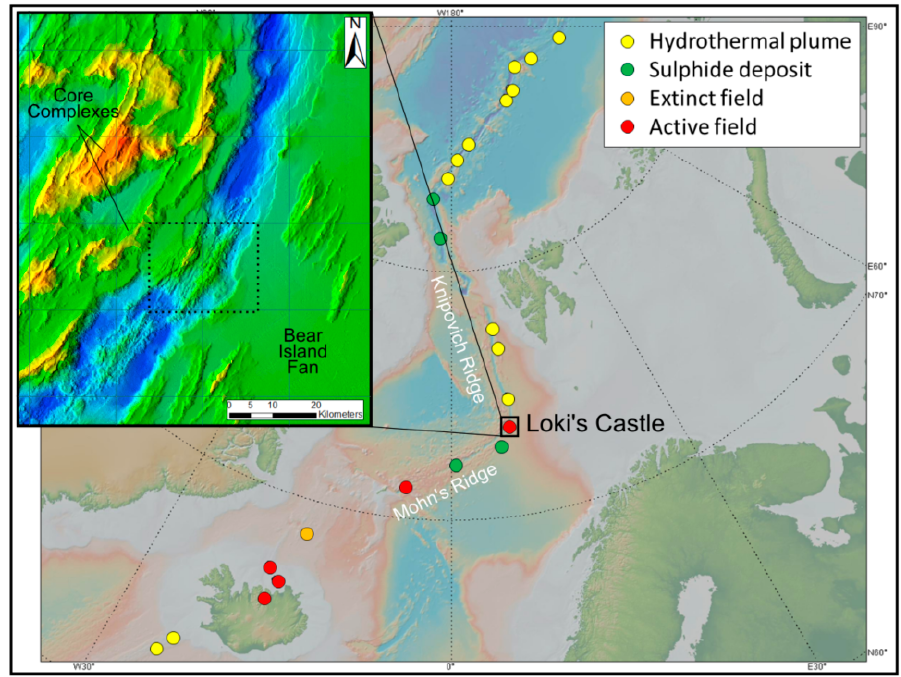
Figure 1. Location of the Loki’s Castle vent, with reference to other discoveries, after data from [8,27,28]. Localised bathymetric inset after data from [29], indicating regional NE–SW striking structures, the Bear Island Fan to the SE and core complexes to the NW, with the area of Figure 2 demarcated.